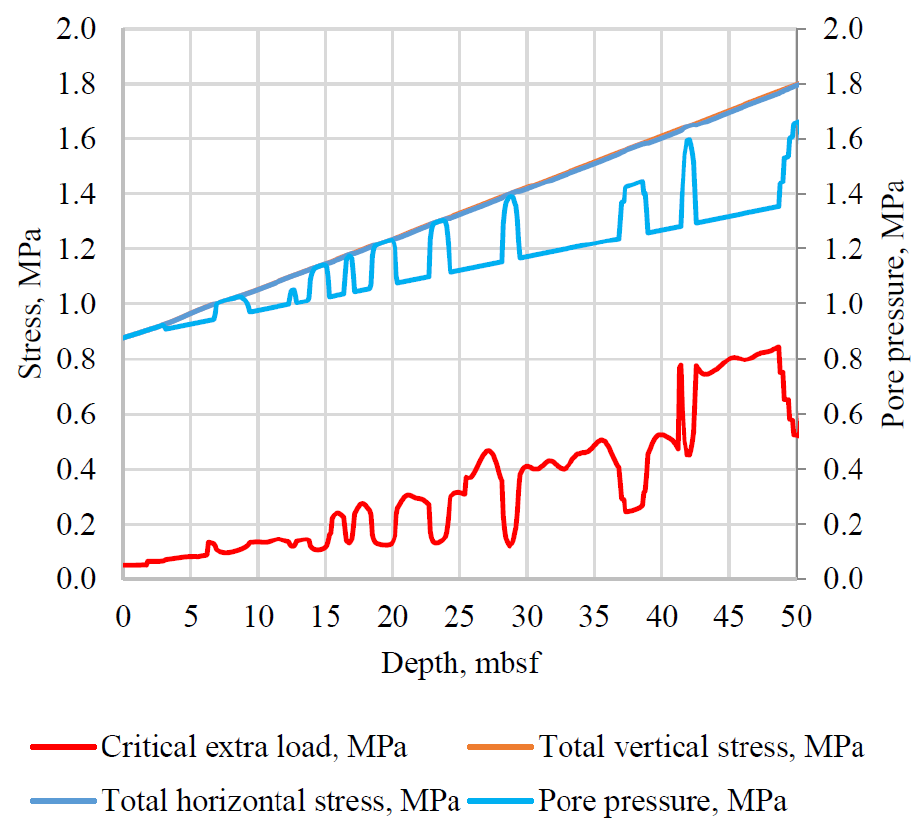
Figure 8. Critical load estimation for consolidation analysis.